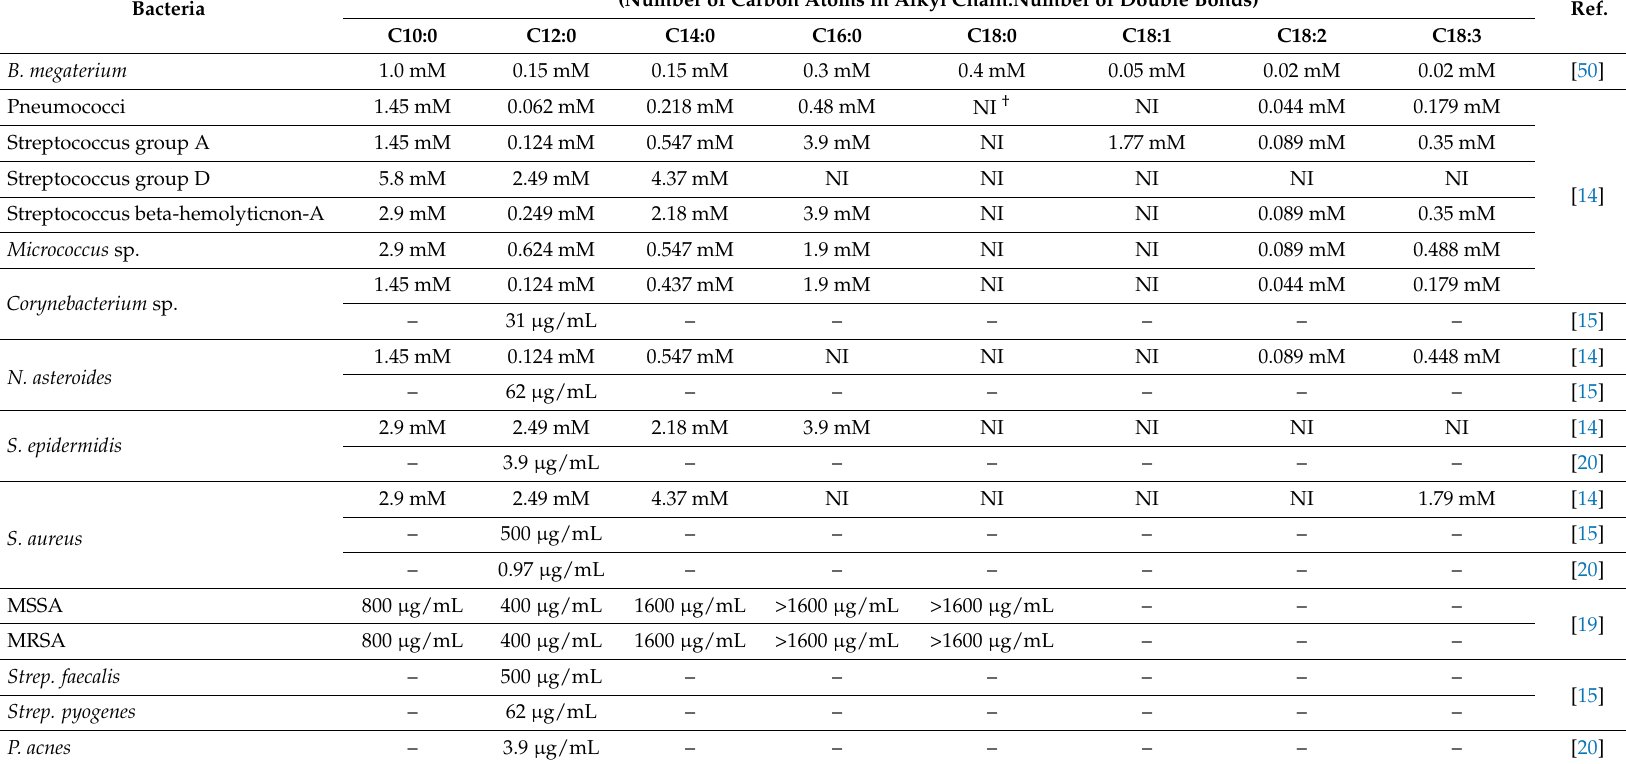
Table 3. Selected MIC values of fatty acids against different Gram-positive